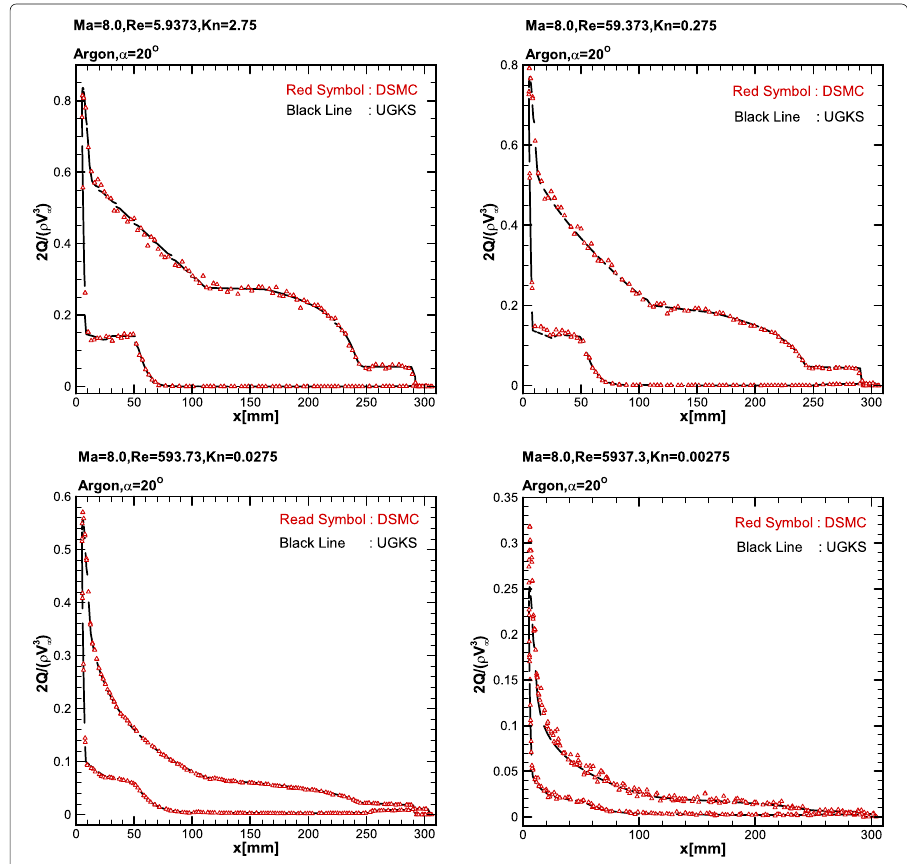
Fig. 6 Comparison of surface heat flux distributions. Red symbol: DSMC; Black line: UGKS